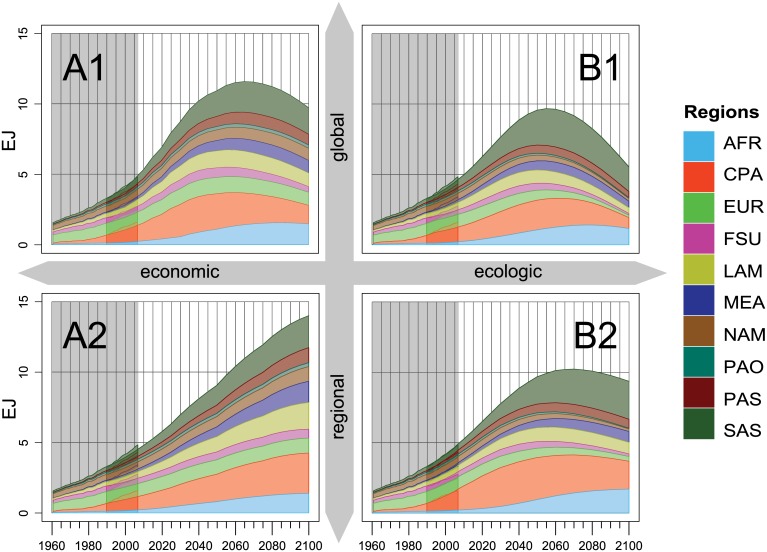
Same as Fig 5 for animal-based food energy demand projections per region over time for 4 SRES scenarios (1018 Joule a−1).